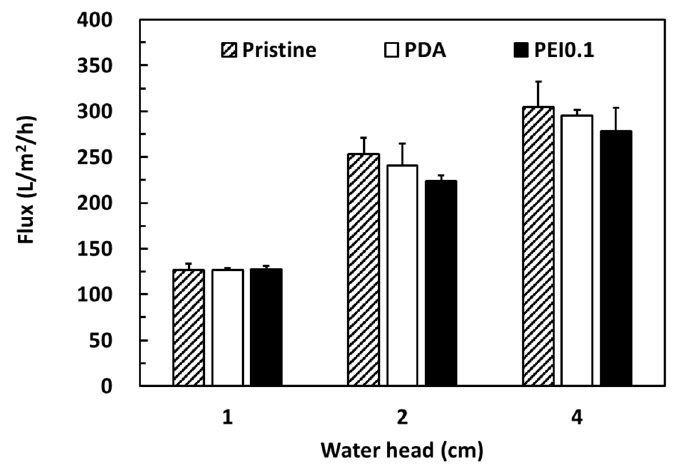
Figure 7. Pure water fluxes of different filter papers.